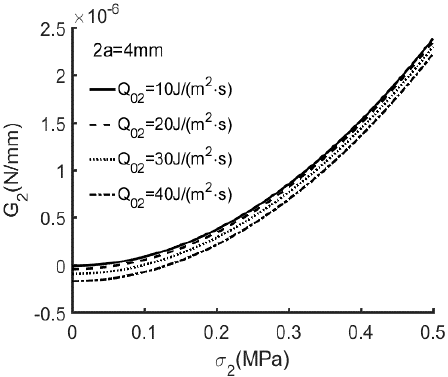
(cid:0) (cid:1) m 2 · s for (cid:118) c = 0 and ε = 0.01.